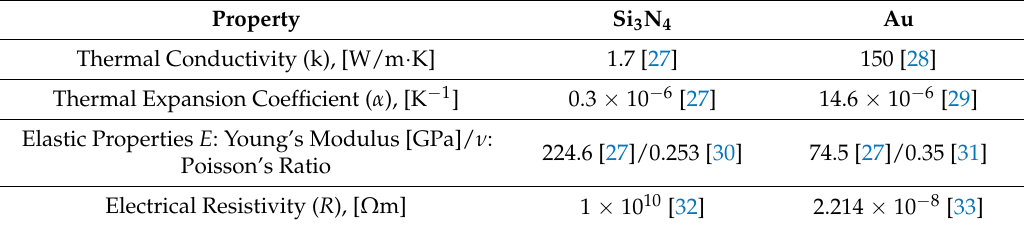
Table 1. Material properties used in this study (data were found from studies on thin metal films).